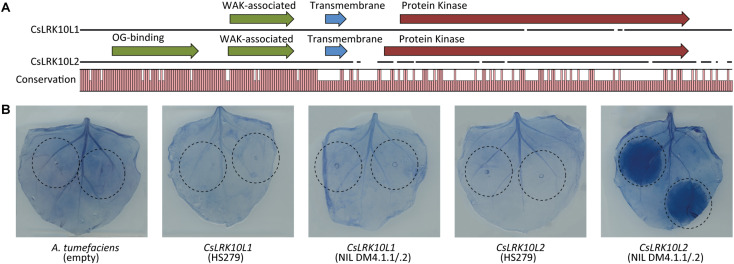
Functional characterization of CsLRK10L genes. (A) Multiple protein sequence alignment of predicted proteins encoded by CsLRK10L1 and CsLRK10L2. A graph indicates conservation per amino acid. Pfam domains as identified by InterProScan v5.27 are indicated by arrows. (B) Alleles of CsLRK10L1 and CsLRK10L2 cloned from cucumber genotypes HS279 and NIL DM4.1.1/.2 were transiently expressed in Nicotiana benthamiana leaves by agro-infiltration (infiltrated leaf areas are indicated). Empty A. tumefaciens cultures were used as a negative control. CsLRK10L2 cloned from NIL DM4.1.1/.2 consistently triggered a necrotic reaction in >20 individual plants. In order to visualize necrotic tissue, leaves were stained using trypan blue.